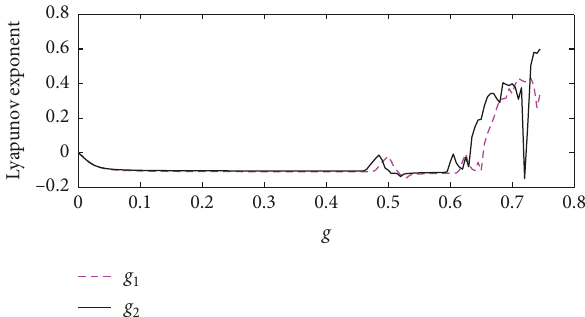
Figure 3: The maximum Lyapunov exponents with p diagram.